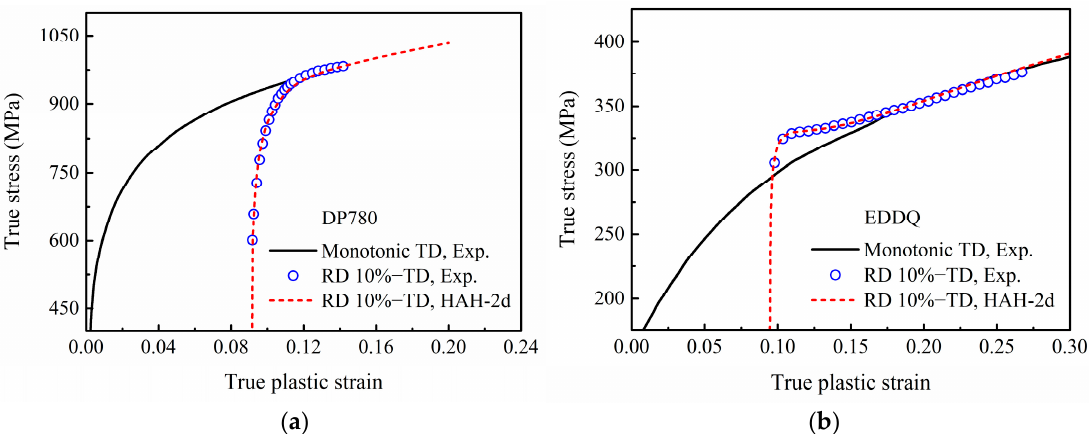
Figure 15. Experimental and predicted stress–strain curves of re-tension in TD with 10% uniaxial pre-strain in RD for: ( a ) DP780 steel and ( b ) EDDQ steel. The experimental data are derived from